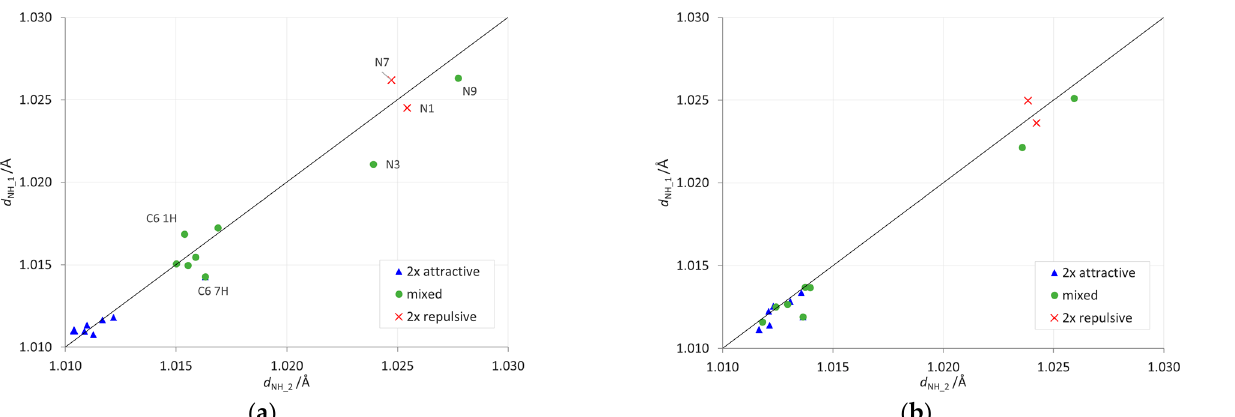
Figure 5. Dependences between the lengths of two NH bonds of the NH 2 group. The y = x line indicates a situation when both have the same length. Data for ( a ) the gas phase and ( b ) the most polar solvent considered, formamide.